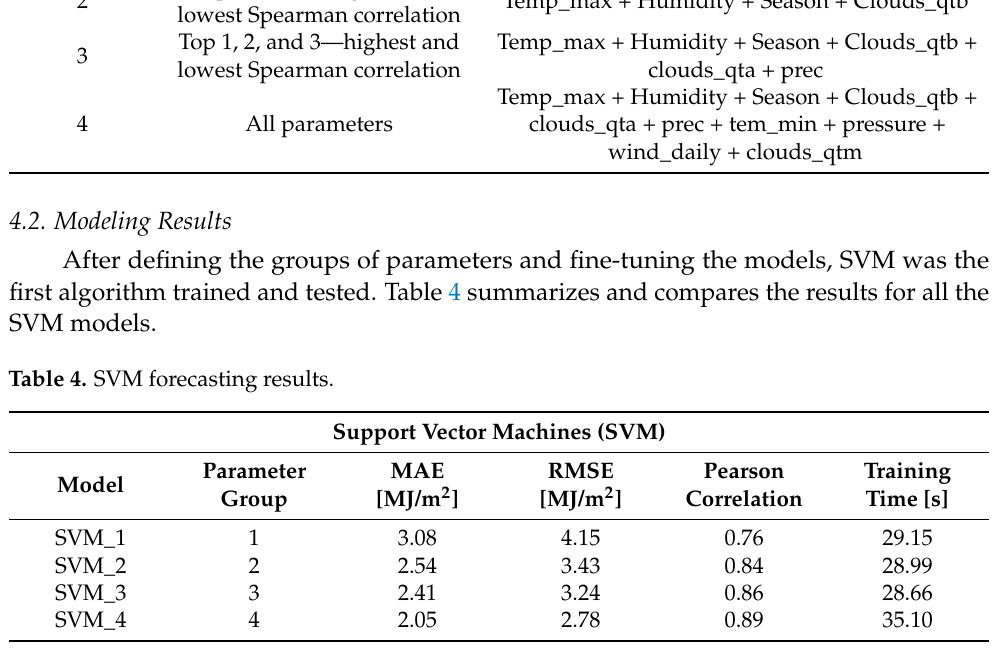
Table 3. Meteorological parameter grouping.